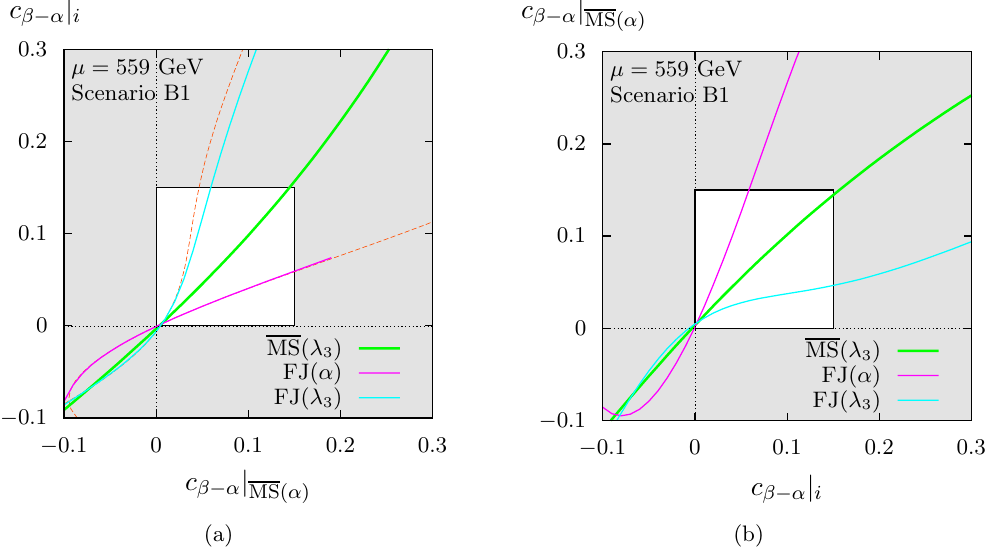
Figure 21 . Panel (a): conversion of the value of c (cid:12) (cid:0) (cid:11) from MS( (cid:11) ) to the other schemes for scenario B1 with the colour coding of (cid:12)gure 8. Panel (b) shows the conversion to the MS( (cid:11) ) scheme. The solid lines are obtained by solving the implicit equations numerically, the dashed orange lines in (a) correspond to the solution of (b) mirrored at the diagonal. The highlighted region shows the phenomenologically most relevant c (cid:12) (cid:0) (cid:11) region.